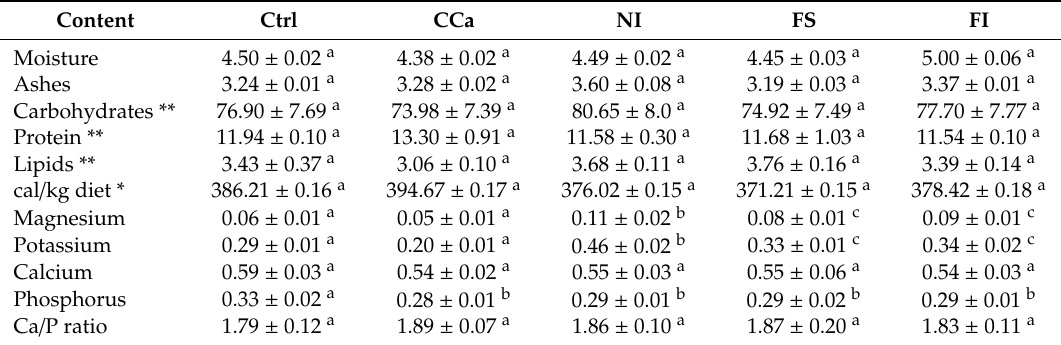
Table 2. Proximate chemical composition, mineral content and Ca / P ratio of control and experimental diets (g / 100